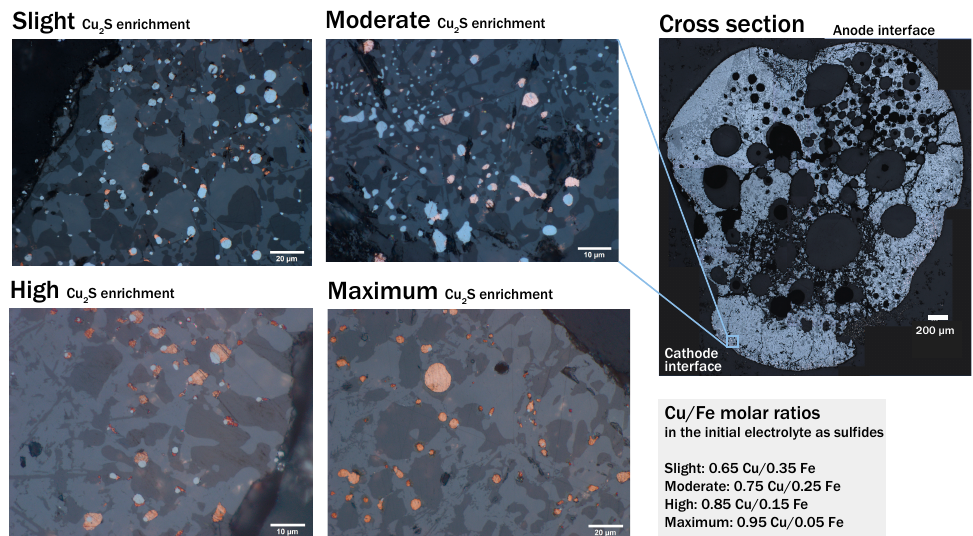
Figure 5. Micrographs of the dispersed metal at the graphite interface reveal that the electrolysis product evolves from being exclusively iron-rich for CuFeS 2 to majority copper-rich as the electrolyte composition is progressively enriched in Cu 2 S. A cross-section of the moderate Cu 2 S-enriched sample shows the extensive porosity observed after electrolysis. The Cu/Fe molar ratios in the initial electrolyte as sulfides for each sample (slight, moderate, high and maximum Cu 2 S enrichment) can be seen in the bottom right corner.